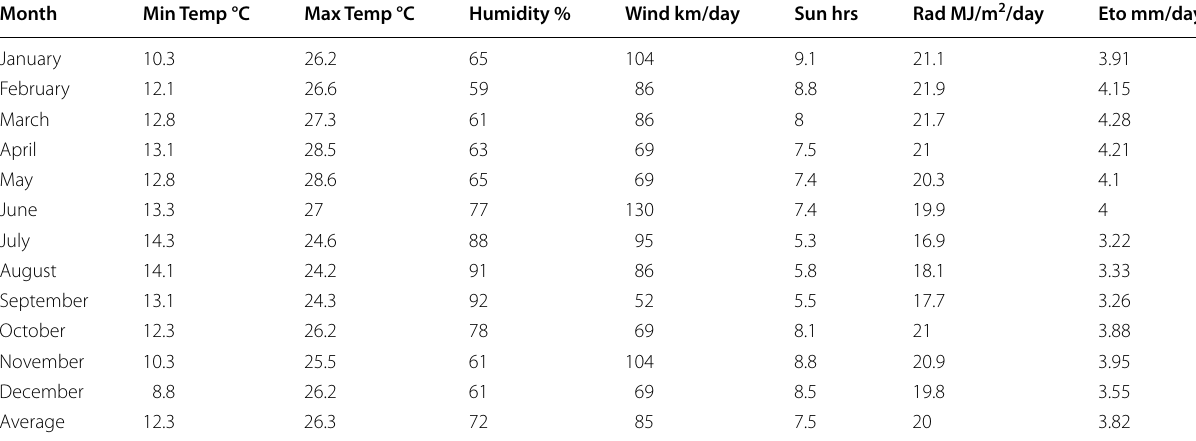
Table 5 Climate and evapotranspiration data